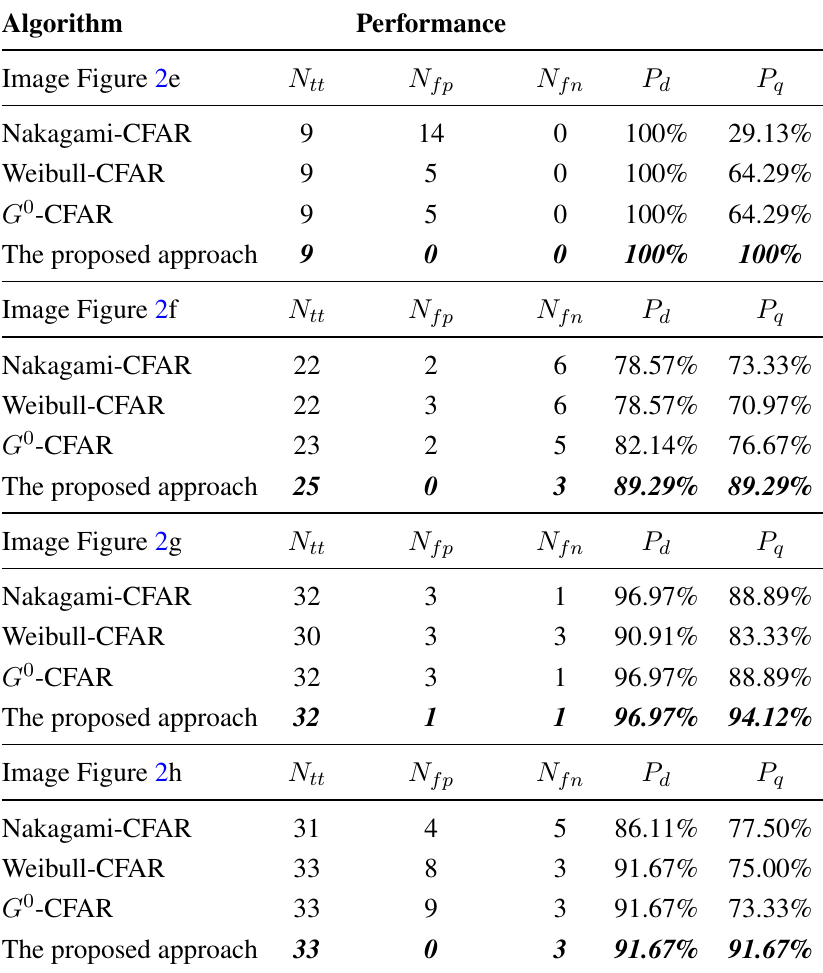
Table 2. Comparison of different detection algorithms in SAR